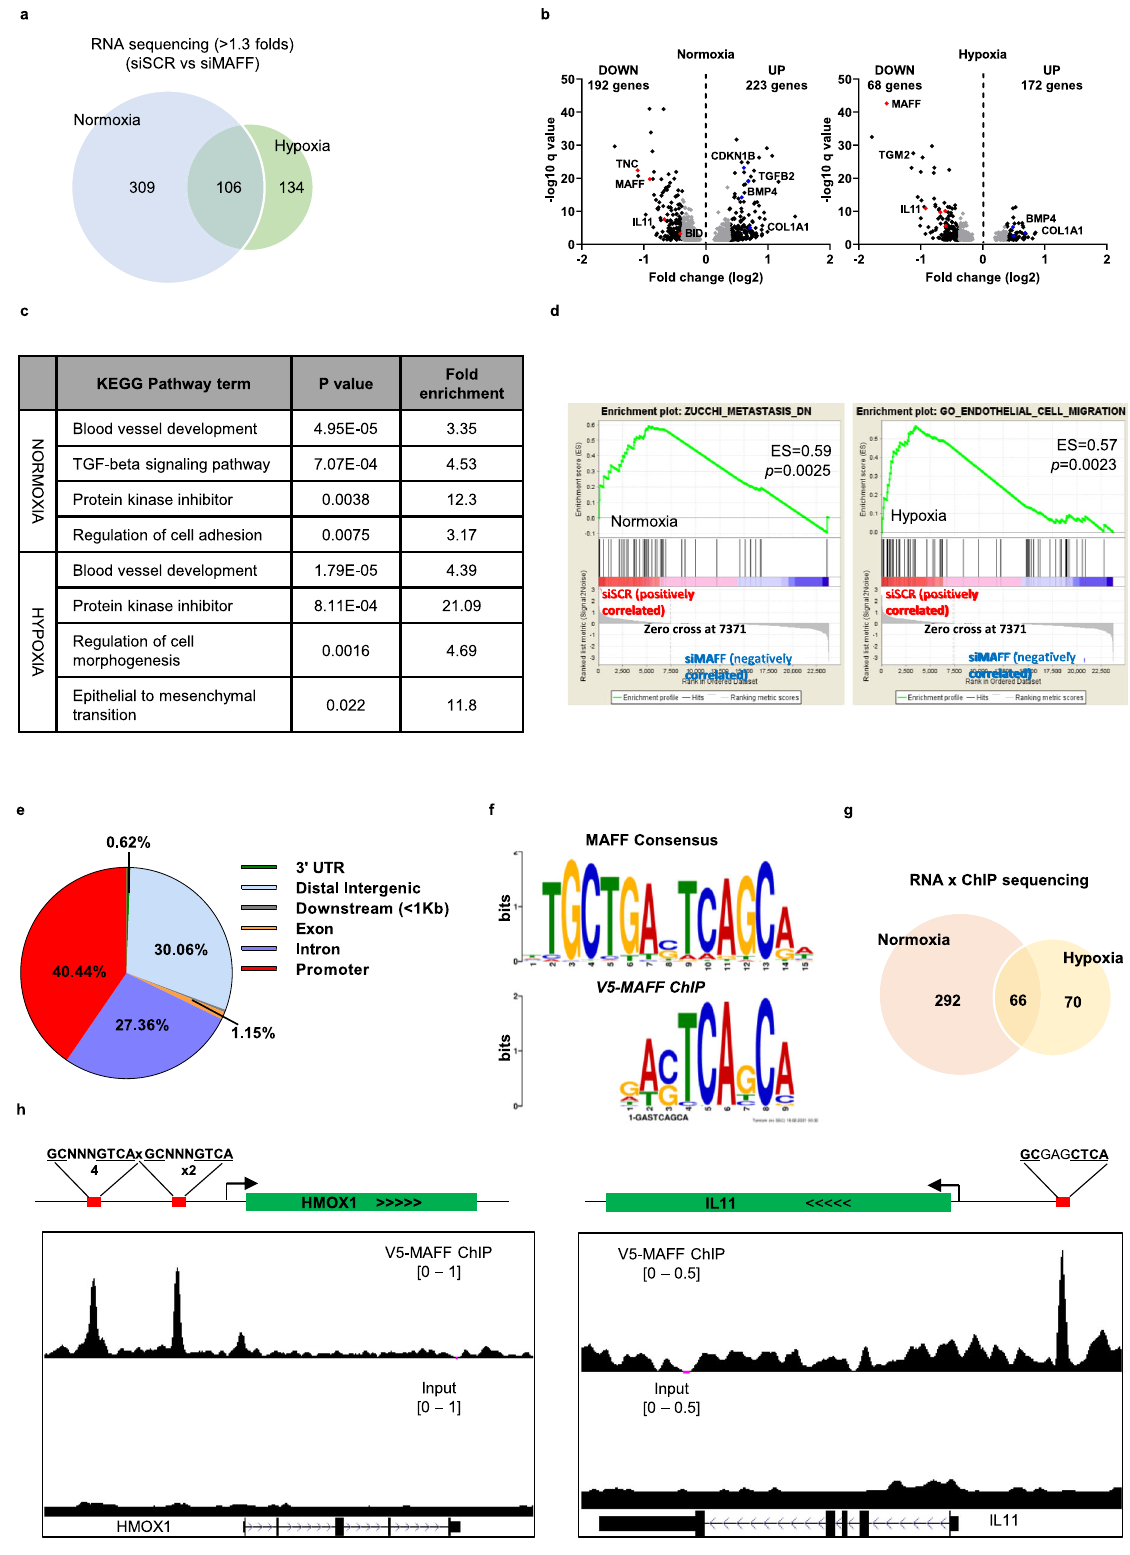
hypoxia (Fig. 7e). Using this same region subcloned into pGL4 luciferase, we found that the expression of IL11 was increased under hypoxia and inhibited under both normoxia and hypoxia (Fig. 7f). When BACH1 or both BACH1 and MAFF were inhibited, tumor cell invasion and tube formation of HUVEC cells were also signi fi cantly decreased (Fig. 7g). The decreases